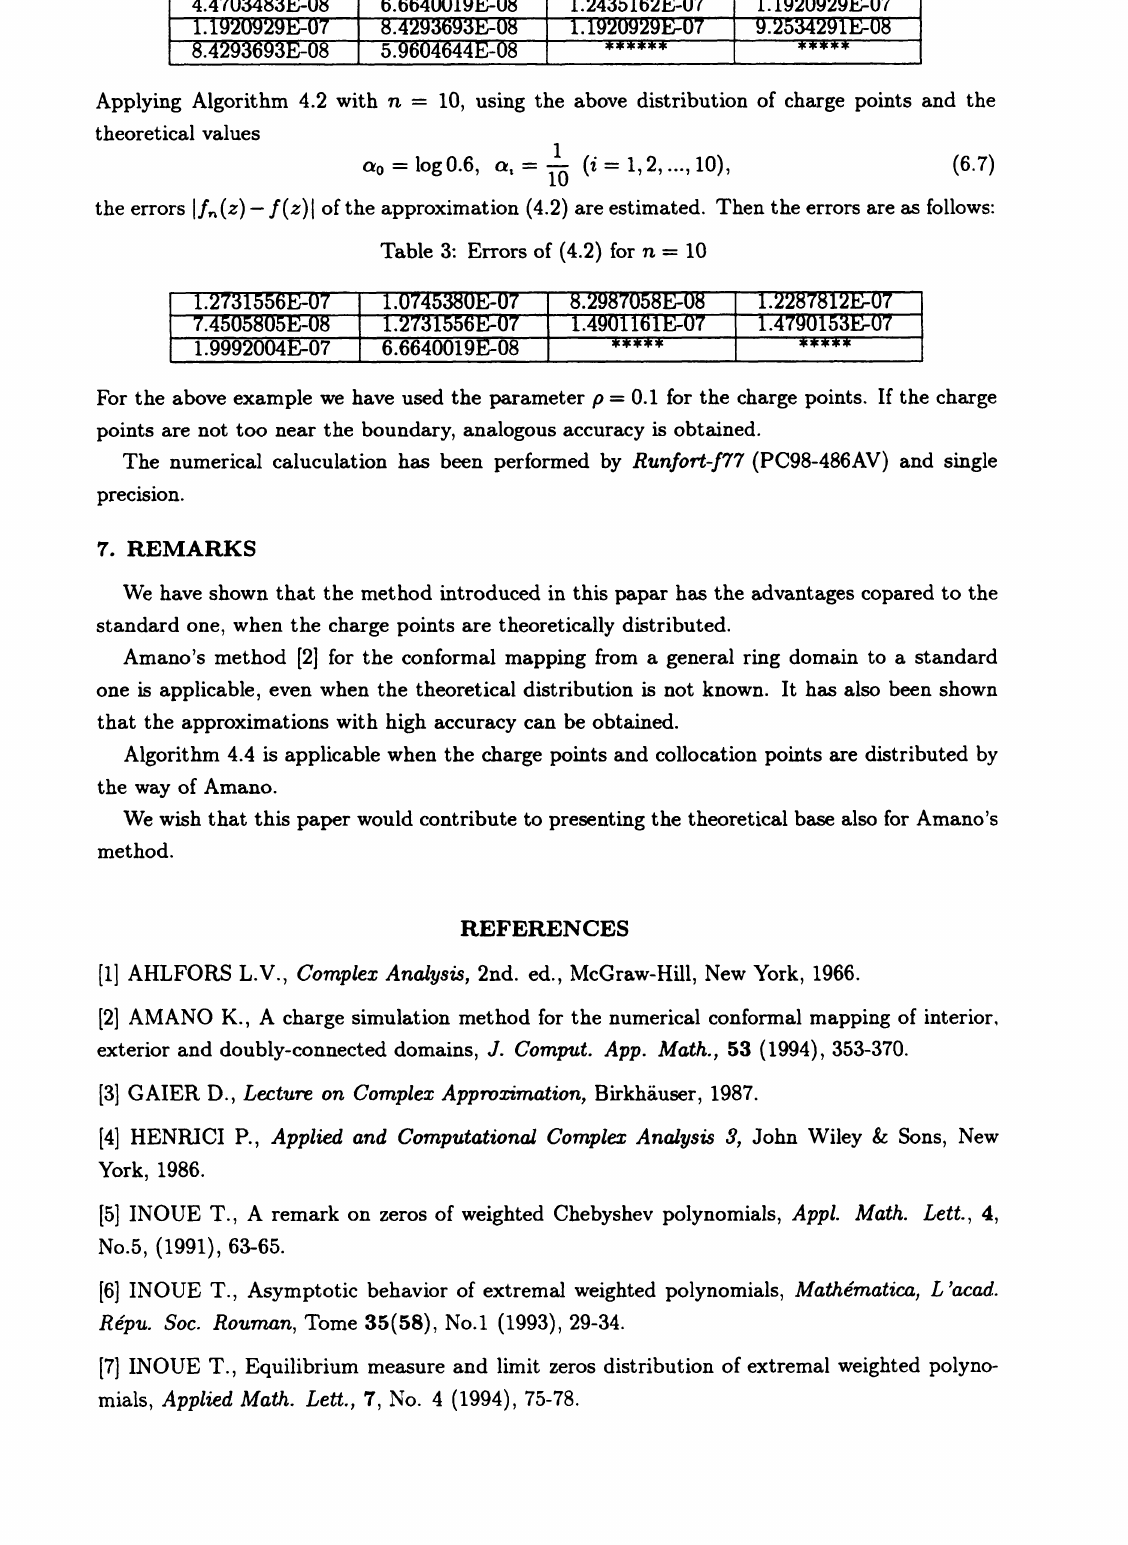
Table 2: Errors of (4.8) for n